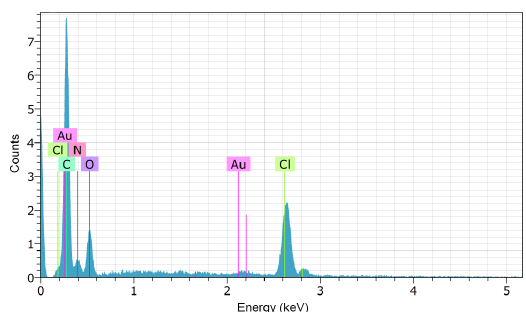
Figure 5. Energy Dispersive X-ray Spectroscopy (EDS) analysis results for the modified-AEM.